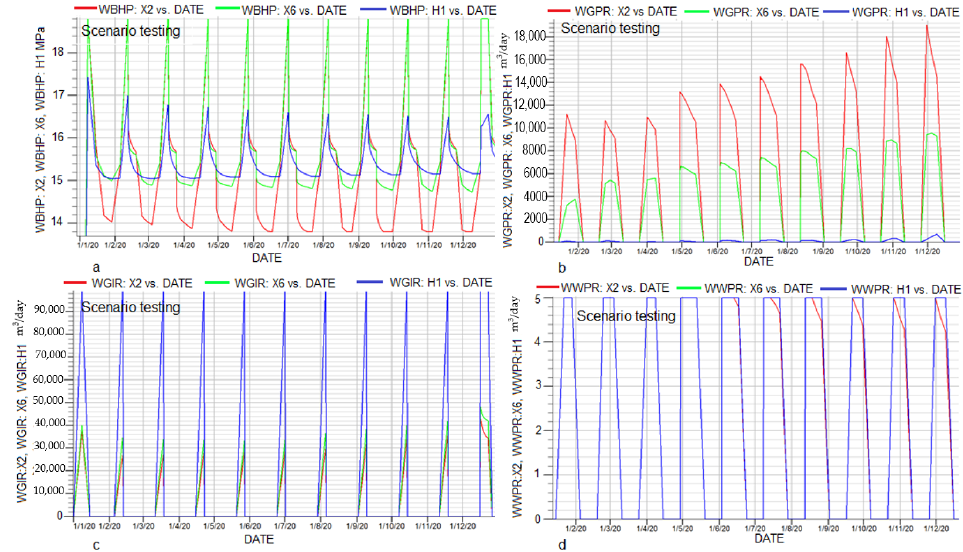
Figure 3. Well properties comparison of the three-well case scenario with the short-term schedule 1wkInj-1wkShut-2wkProd-1wkShut for one year. X2 and X6 are vertical wells, and H1 is the horizontal well: ( a ) well bottom hole pressure (WBHP) of all wells; ( b ) production gas rates (WGPRs) for all three wells; ( c ) injection gas rates (WGIRs) for all three wells and; ( d ) well water production rate (WWPR) for all the wells.